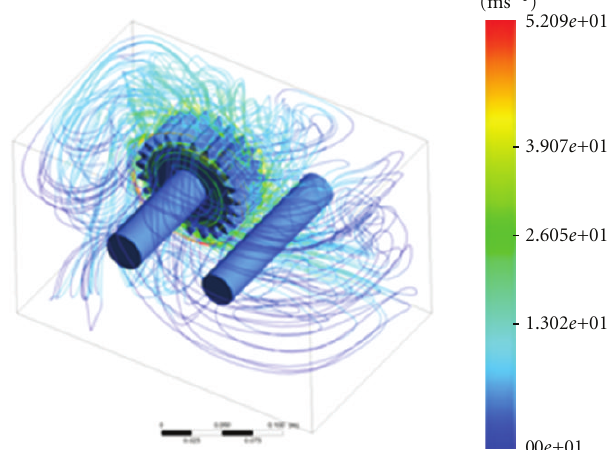
Figure 8: Velocitystreamlines; b = 40 mm; d = 102 . 5 mm; T = 90 ◦ C; n = 8000